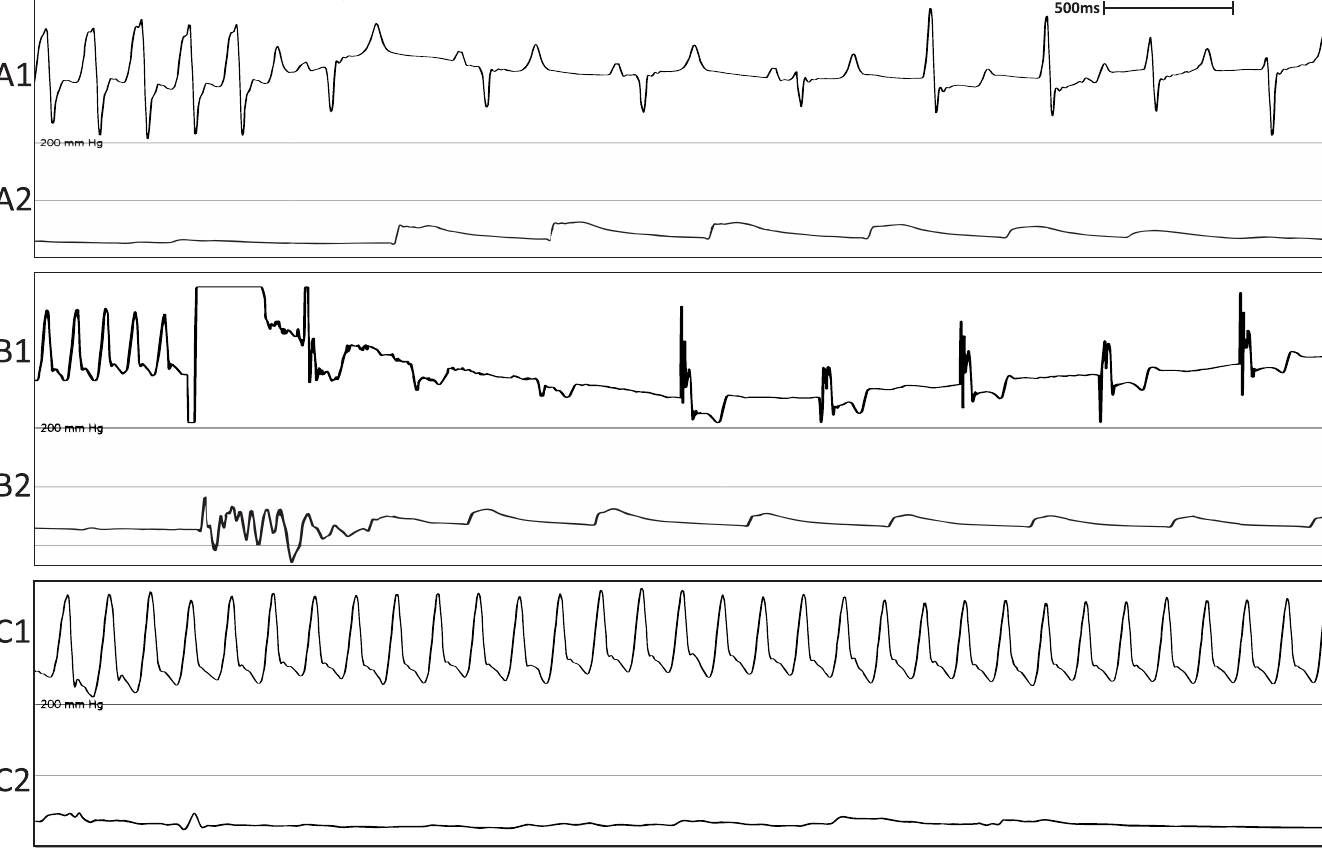
Fig 8. Representative surface ECG recordings showing VT and VF experienced during the ablation procedure. (A1) Surface ECG showing non-sustained VT. (A2) Mean arterial blood pressure trace indicating return of normal blood pressure following termination of VT. (B1) Surface ECG showing cardioverted VF. (B2) Mean arterial blood pressure trace indicating return of normal blood pressure following cardioversion of VF. (C1) Surface ECG showing VF causing death. (C2) Mean arterial blood pressure trace showing no blood pressure during VF.